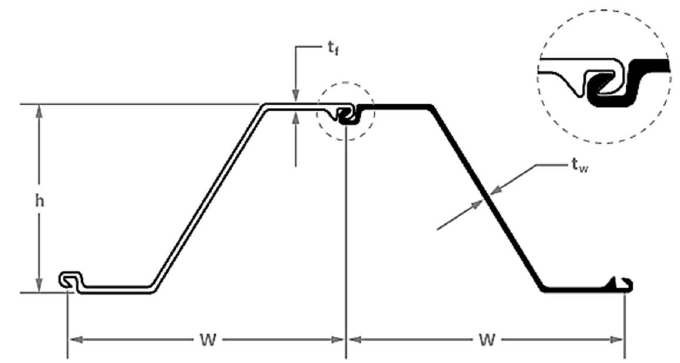
Figure 2. Sheet pile wall pre-fabricated sections